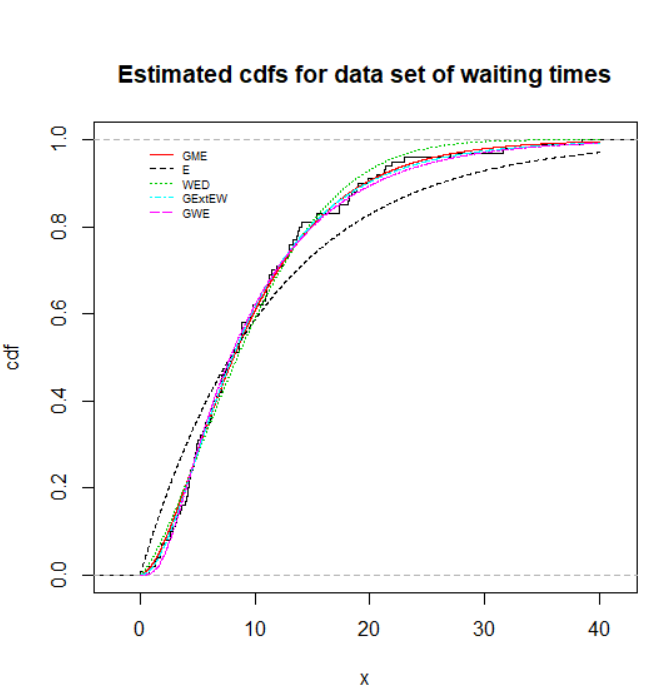
Figure 8. Fitted pdfs and the relative histogram, empirical and fitted